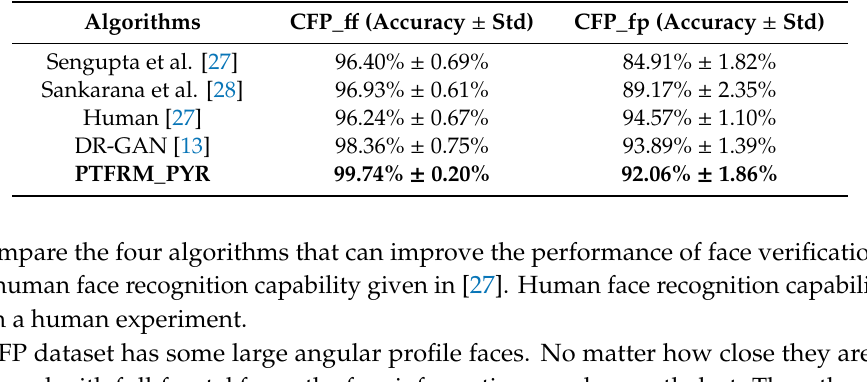
Table 3. Accuracy of related algorithms on the CFP test